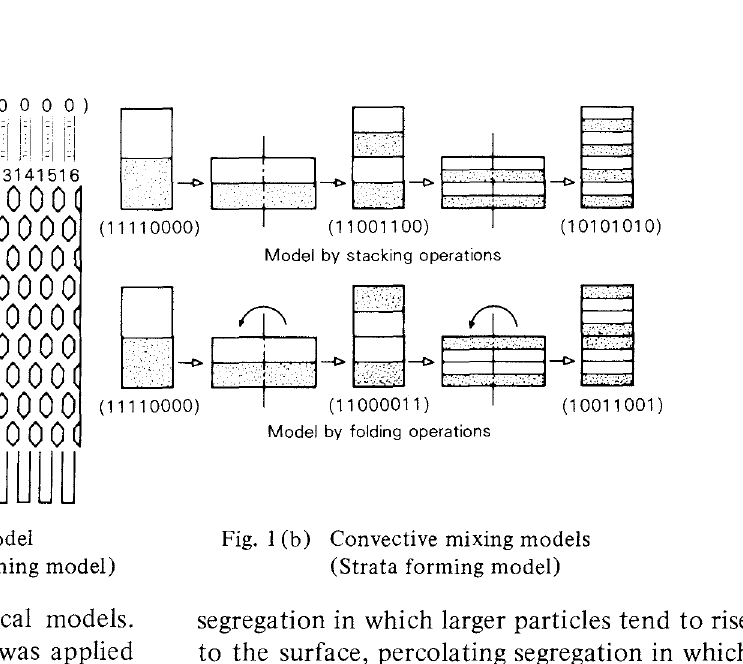
Fig. 1 (b) Convective mixing models (Strata forming